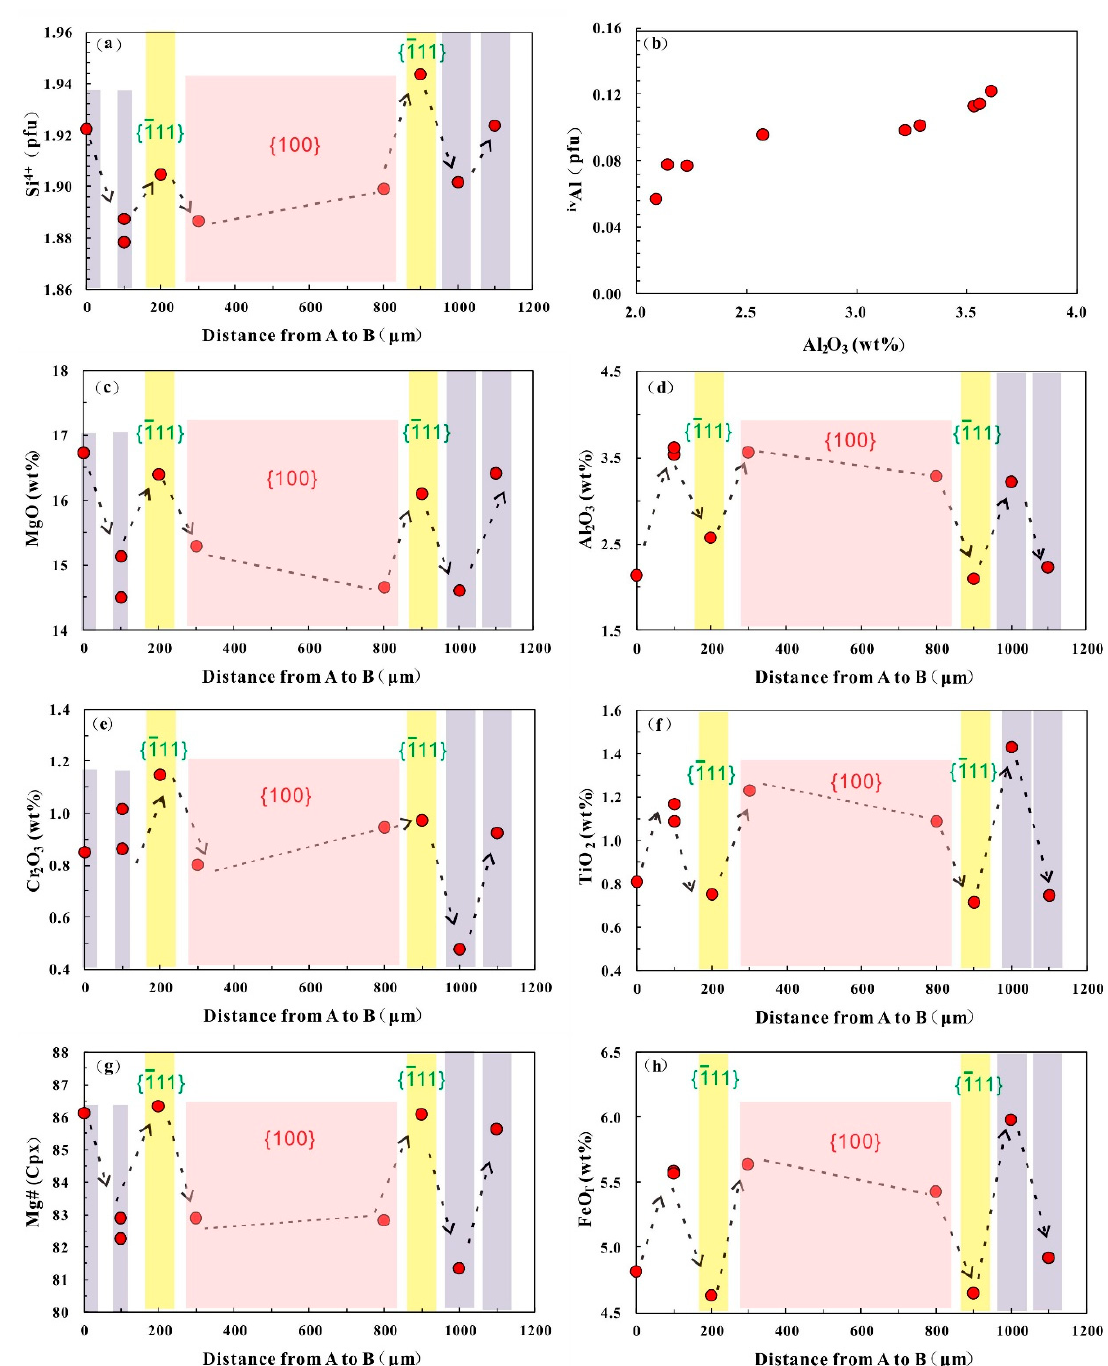
Figure 7. Elemental profiles (A to B) for the zoned Cpx phenocryst of the high-Mg basalt sample YY13-111. Profile analysis shows oscillatory zonings in the elements of Si, Mg, Cr, Ti and Al. The MgO and Cr 2 O 3 show strong negative correction with the Al 2 O 3 , TiO 2 and FeO. The {100} shows Al 2 O 3 , TiO 2 FeO enrichment compared with the {-100}. ( a – h ) Major elements variations along the line (from A to B).